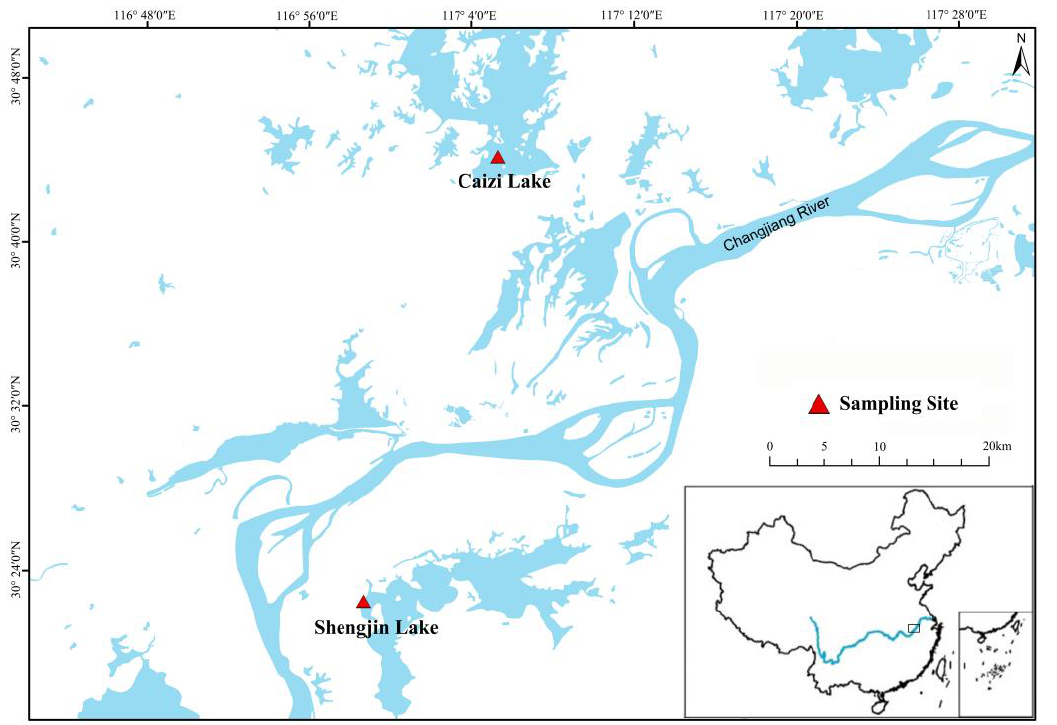
Figure 1. Sampling distribution diagram. Table 1. Information form of Anser fabalis fecal sample